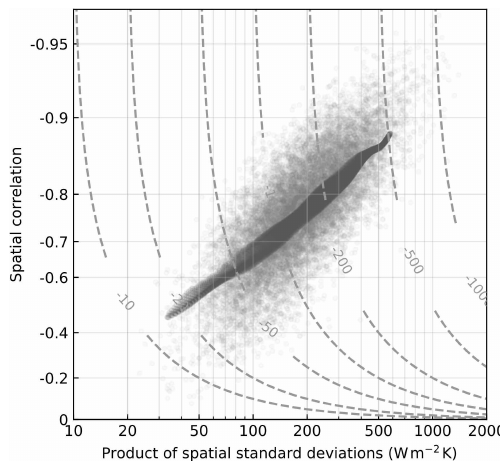
Figure 7. Scatter plot of F (cid:48) – T (cid:48) spatial correlation against the prod- uct of F (cid:48) and T (cid:48) standard deviations using kernel-averaged data points from phase portrait (dark shading) and raw data (grey dots); grey contours (Wm − 2 K) indicate FT index